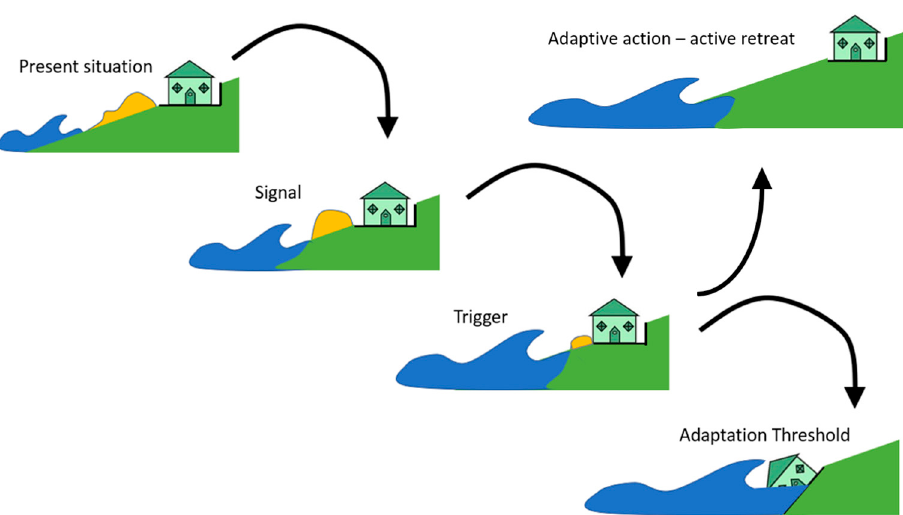
Figure 2. An example sequence of events under climate change. DAPP uses the trigger to instigate a change in action to avoid the adaptation threshold occurring.